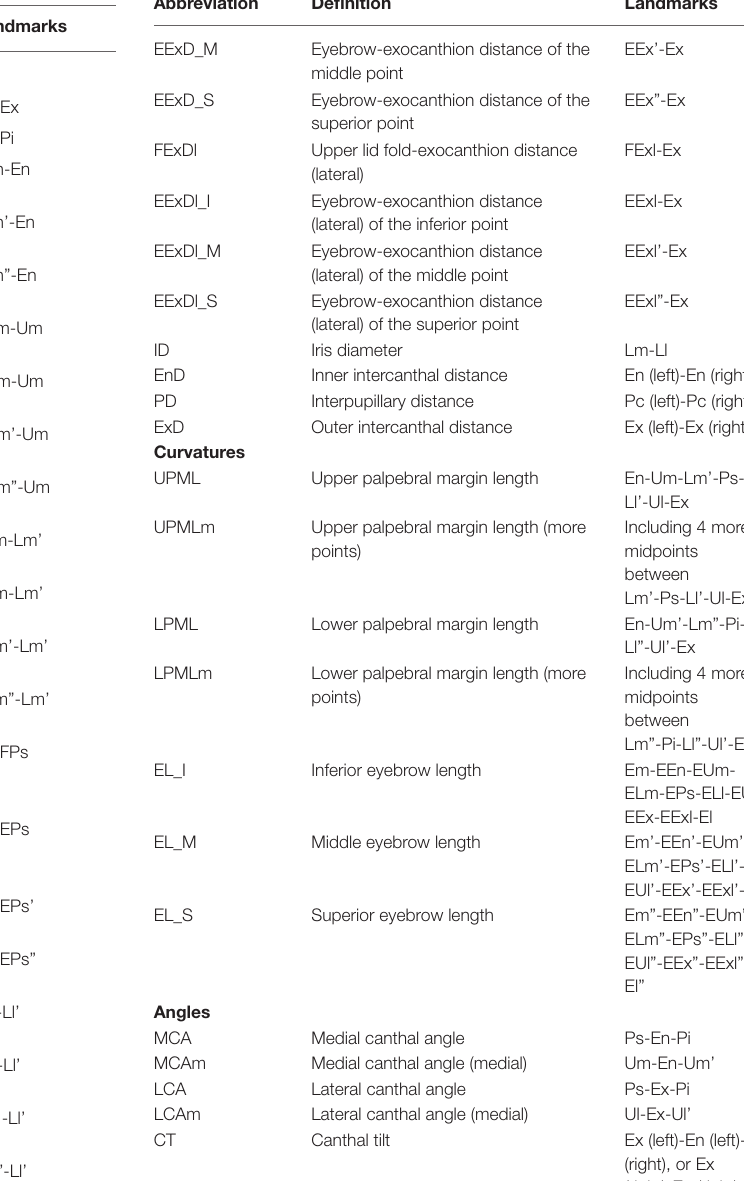
TABLE 2 | List of linear distance, curve, and angle measurement variables for the periocular region, derived from Guo et al.